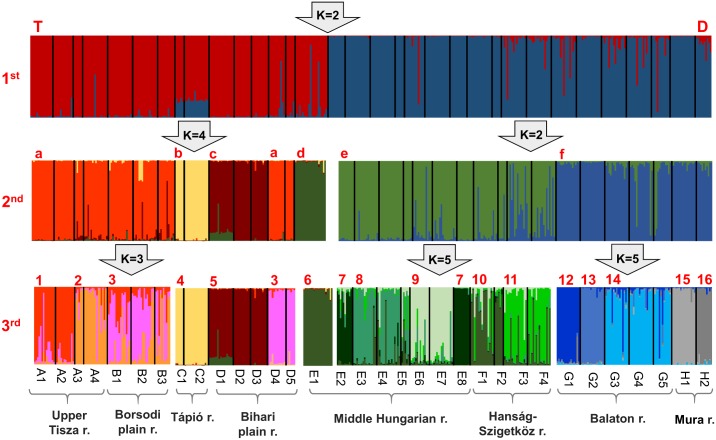
Estimated population structure as inferred by three rounds of hierarchical structure analyses.Each individual is represented by a thin horizontal line, which is partitioned into K-coloured segments representing individual’s estimated membership fractions in K
clusters. Black lines separate individuals from different sampling sites. The most probable K for a sample, given by the arrows, is based on the results of StructureHarvester using the Evanno method. Codes of sampling sites correspond to those of Table 1. Red codes represented on the three hierarchical levels correspond to the codes used in Fig 6.